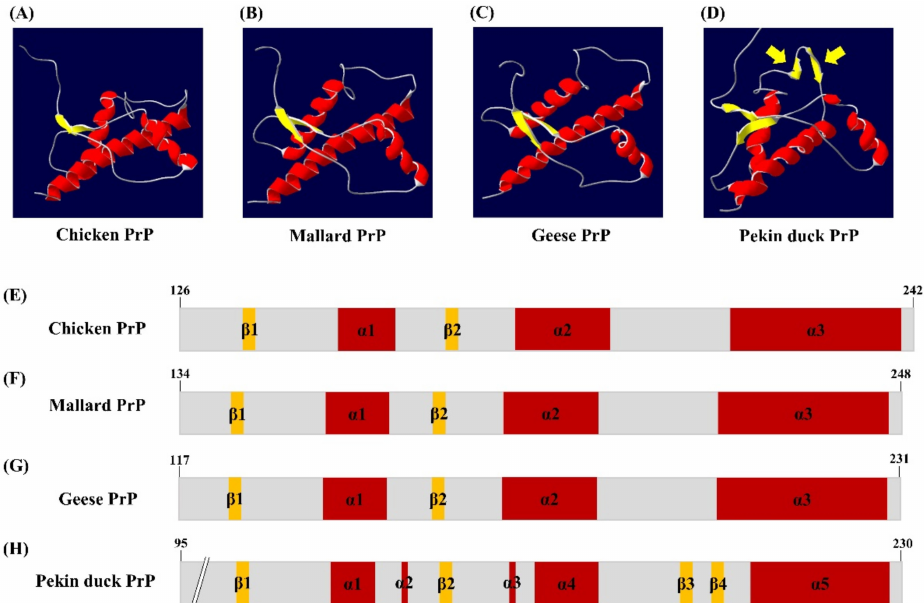
Figure 2. The tertiary and secondary structure of avian prion proteins (PrPs). The diagram of the tertiary structure model and schematic representation of the secondary structure of avian PrPs was constructed by SWISS-MODEL and Swiss PDB Viewer. ( A ) The tertiary structure of the chicken PrP. ( B ) The tertiary structure of the mallard PrP. ( C ) The tertiary structure of the goose PrP. ( D ) The tertiary structure of the Pekin duck PrP. The yellow arrows indicate additional β -sheet structures. ( E ) The secondary structure of the chicken PrP. ( F ) The secondary structure of the mallard PrP. ( G ) The secondary structure of the goose PrP. ( H ) The secondary structure of the Pekin duck PrP. The colors highlight α -helices (red), β -sheets (yellow) and coils